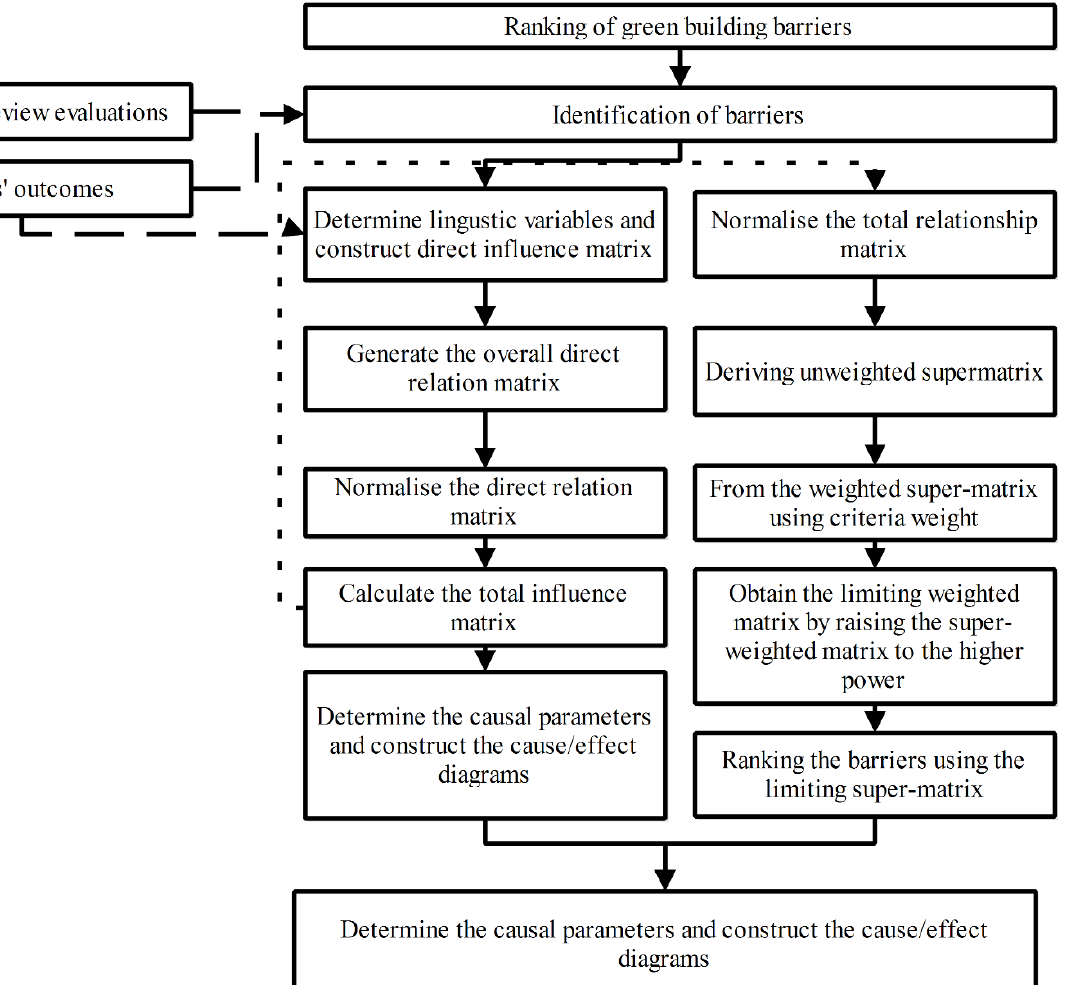
Figure 3. Proposed research framework.